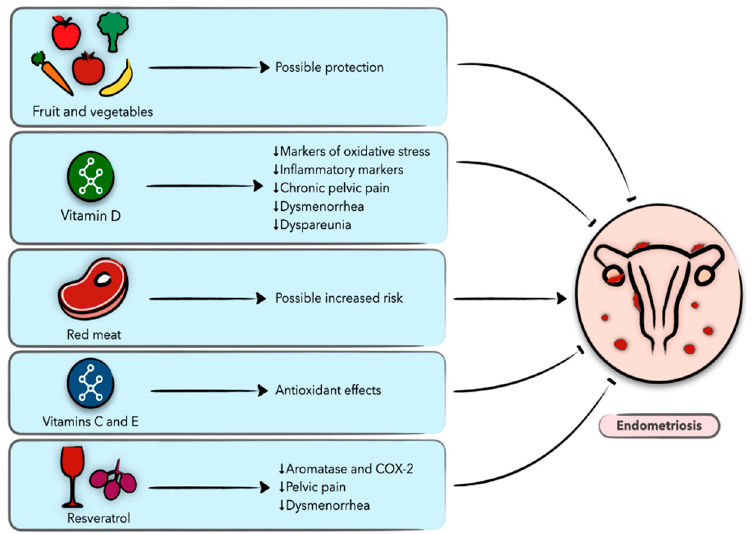
Figure 2. Schematic presentation of the role of diet and nutrition in endometriosis and the possible underlying biological mechanisms. underlying biological